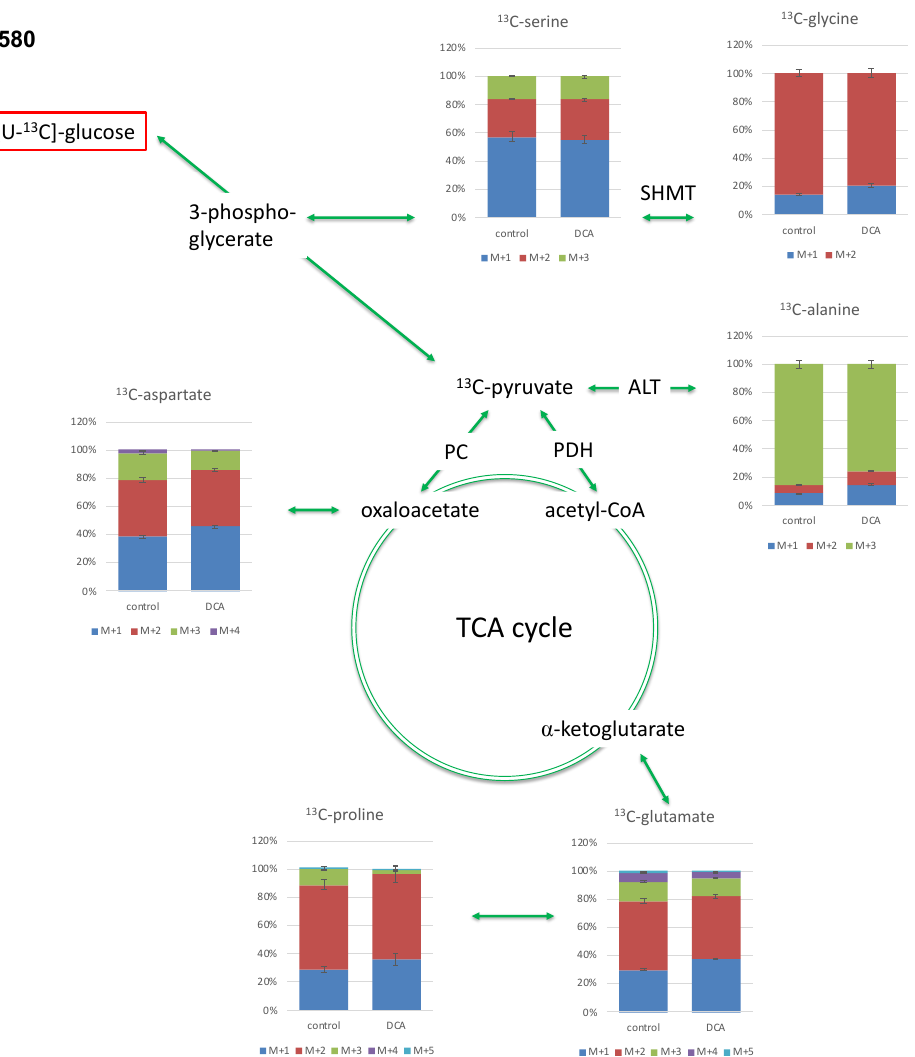
Figure 4. 13 C isotopologue profiles of serine, glycine, alanine, glutamate, proline and aspartate following incubation of 9580 cells with DCA compared to untreated controls. Relative fractions of isotopologues (M + 1–M + 5) in the overall 13 C-labelled amino acids are indicated by different colors. ALT: alanine aminotransferase; PC: pyruvate carboxylase; PDH: pyruvate dehydrogenase; SHMT: serine hydroxymethyltransferase; N = 3.